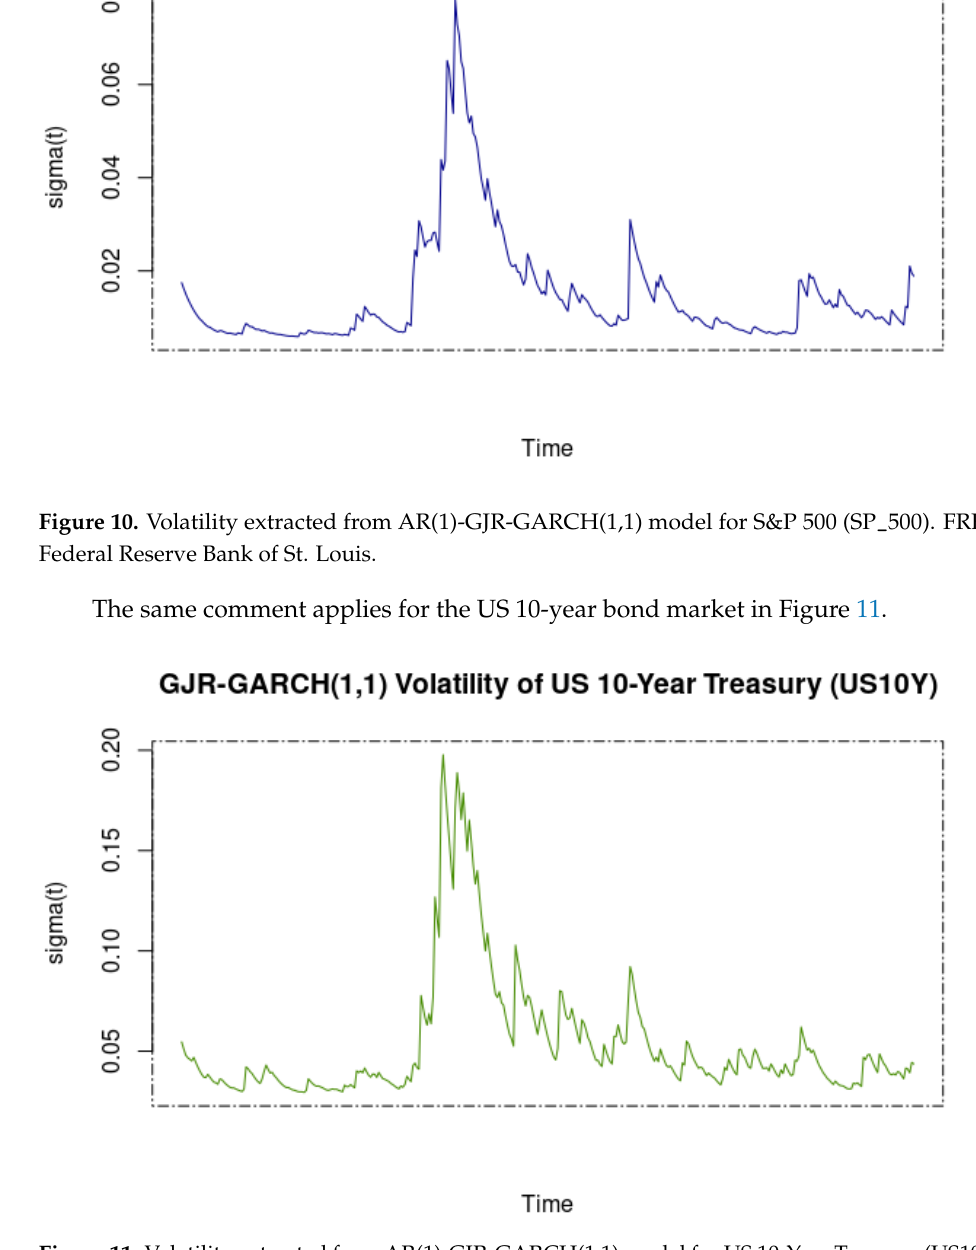
Figure 11. Volatility extracted from AR(1)-GJR-GARCH(1,1) model for US 10-Year Treasury (US10Y)— Reuters’